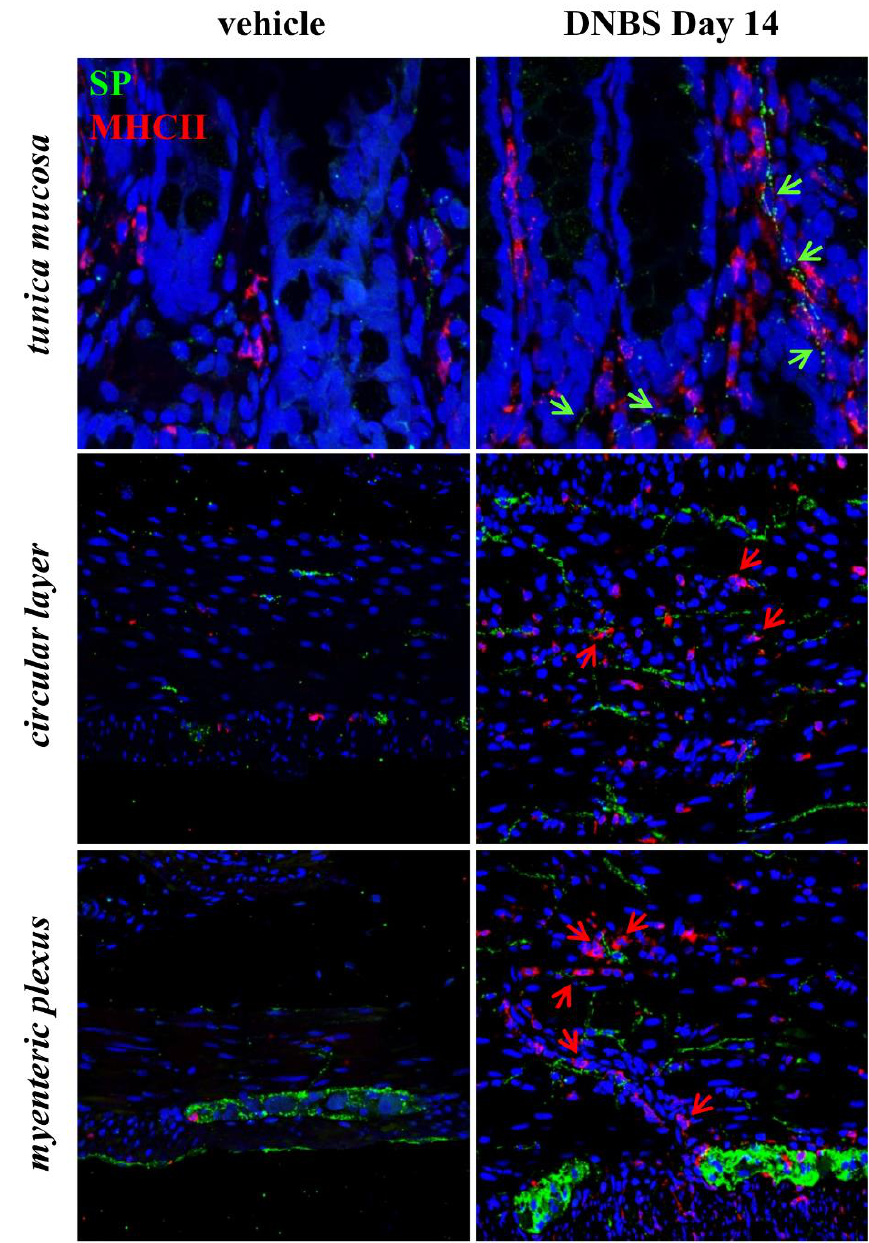
Figure 6. MHC-II cell infiltration of the colonic wall along with SP-immunostained fibers 14 days after DNBS injection. Confocal microscopy representative images of SP (green) / MCHII (red) double-immunolabelled colon from control rats and DNBS-treated rats ( n = 4 animals for each group). SP-immunostained fibers and MHCII-positive cells are highlighted by green and red arrows, respectively. Original magnification: 80× ( tunica mucosa ), 40× ( tunica muscularis ).